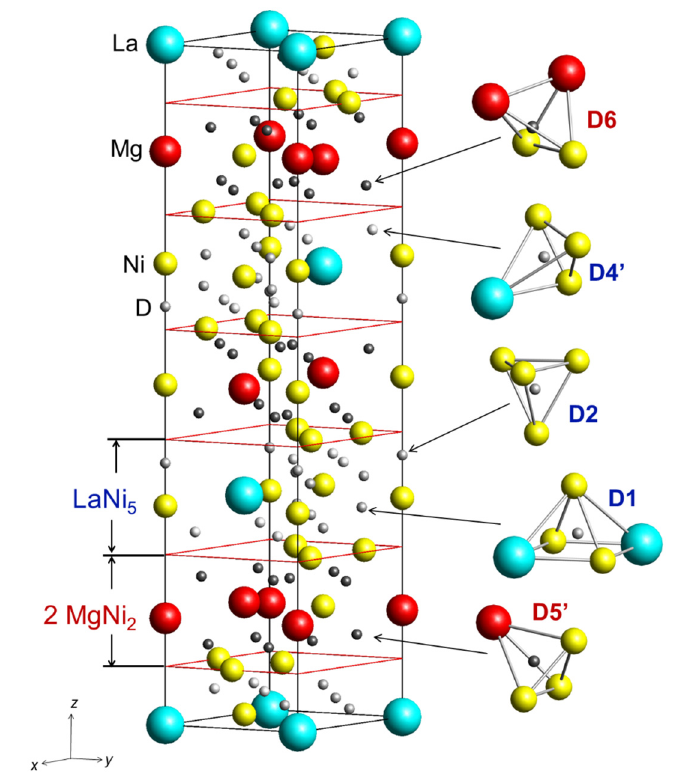
Figure 5. Crystal structure of La 1±0.1 Mg 2±0.1 Ni 9 D 9.4 − 9.5 and types of the filled